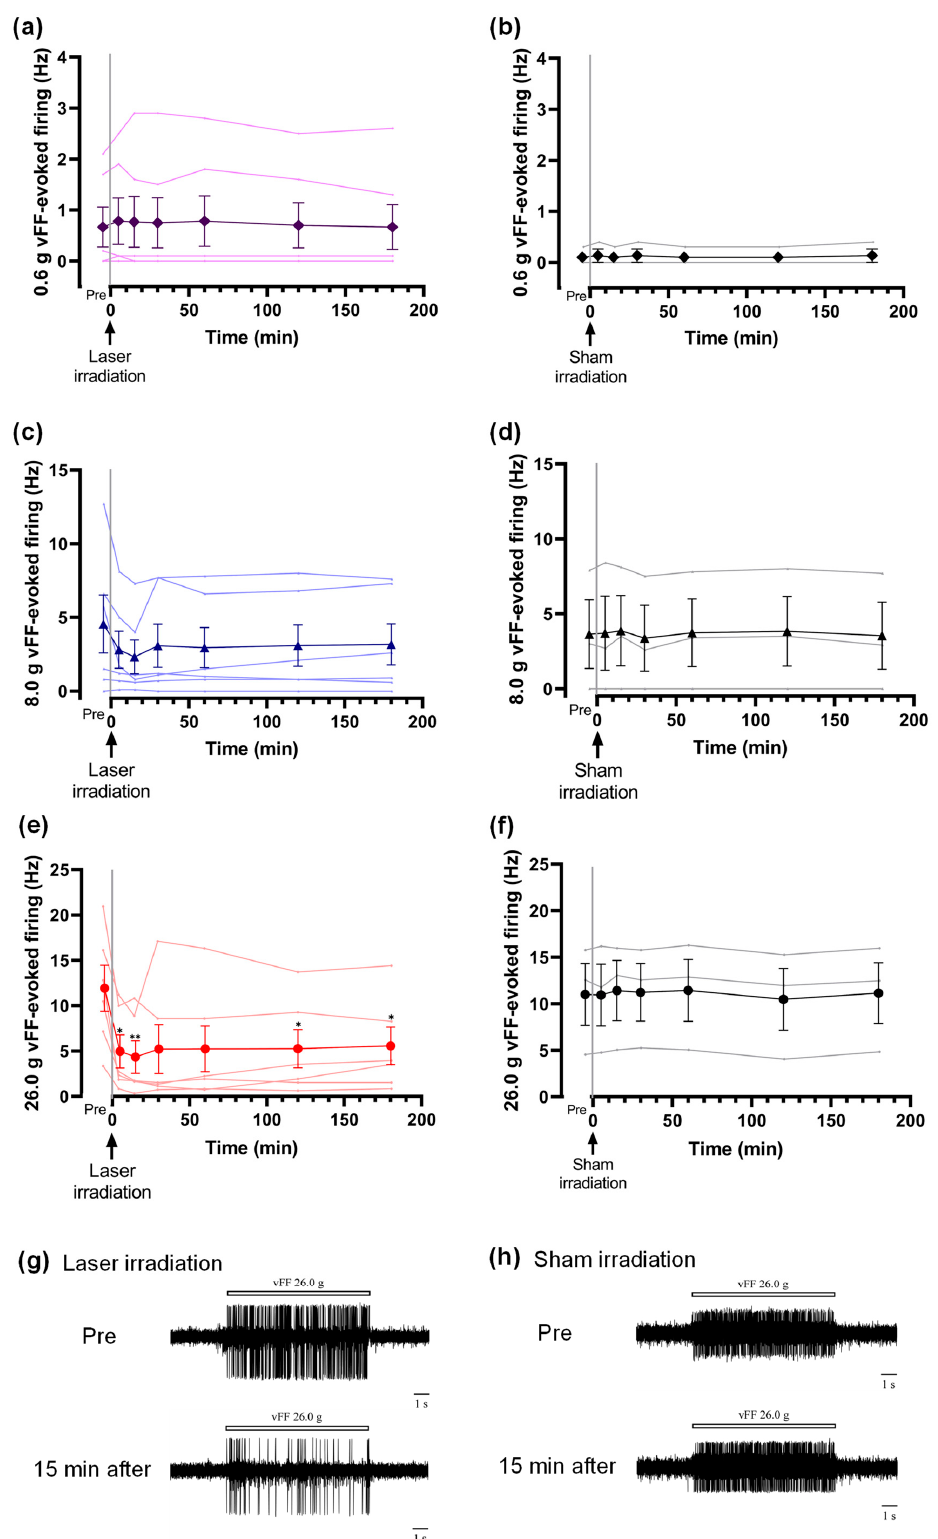
Figure 2. Effects of laser irradiation on the neuronal firing in lamina II of the spinal dorsal horn evoked by mechanical stimulation. ( a ) Laser irradiation did not affect the 0.6 g vFF-evoked firing. ( b ) Sham irradiation did not change the 0.6 g vFF-evoked firing. ( c ) Laser irradiation did not signifi- cantly inhibit the 8.0 g vFF-evoked firing. ( d ) Sham irradiation did not affect the 8.0 g vFF-evoked